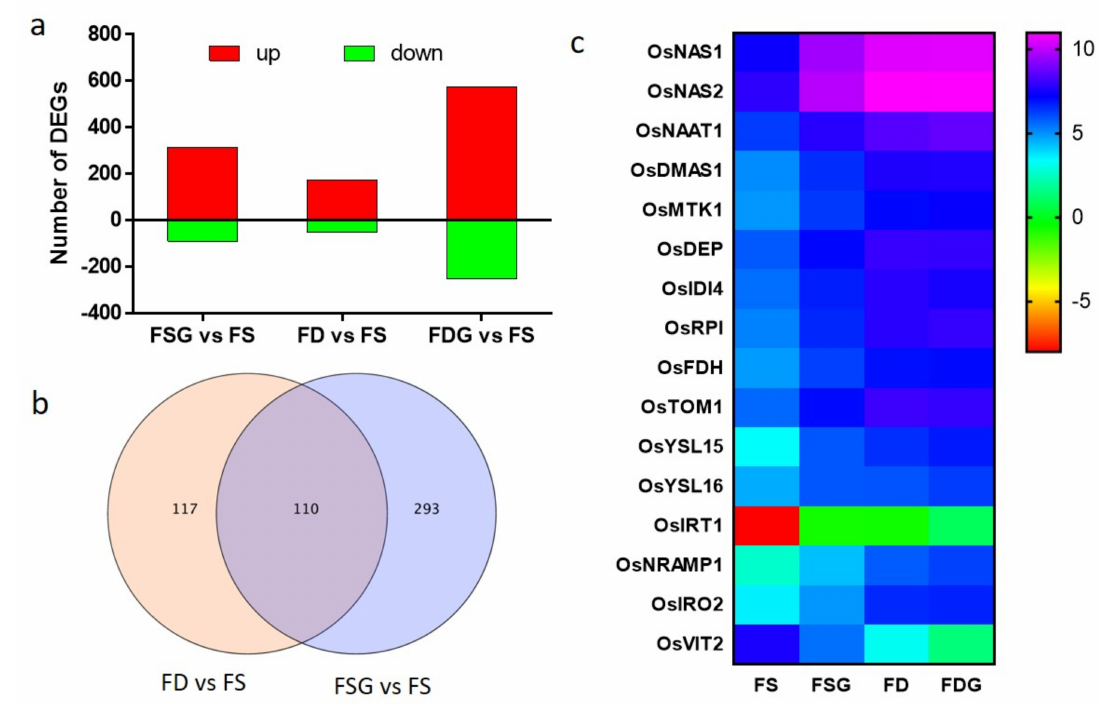
Figure 6. Overview of the changes in transcripts in roots treated with GABA with or without Fe supply. ( a ) Numbers of differentially expressed genes (DEGs) in roots treated with GABA under conditions of Fe-sufficiency (FSG) or -deficiency (FDG) compared to the control (FS). ( b ) Venn diagram of genes regulated by Fe deficiency (FD vs. FS) or GABA (FSG vs. FS) in roots. ( c ) Expression profiles of iron-related genes in roots. The gene -normalized signal intensities are shown in the heat maps using a log2 scale. Two-week-old seedlings were grown in the medium containing 0.5 mM GABA with or without 20 µ M FeSO 4 for three